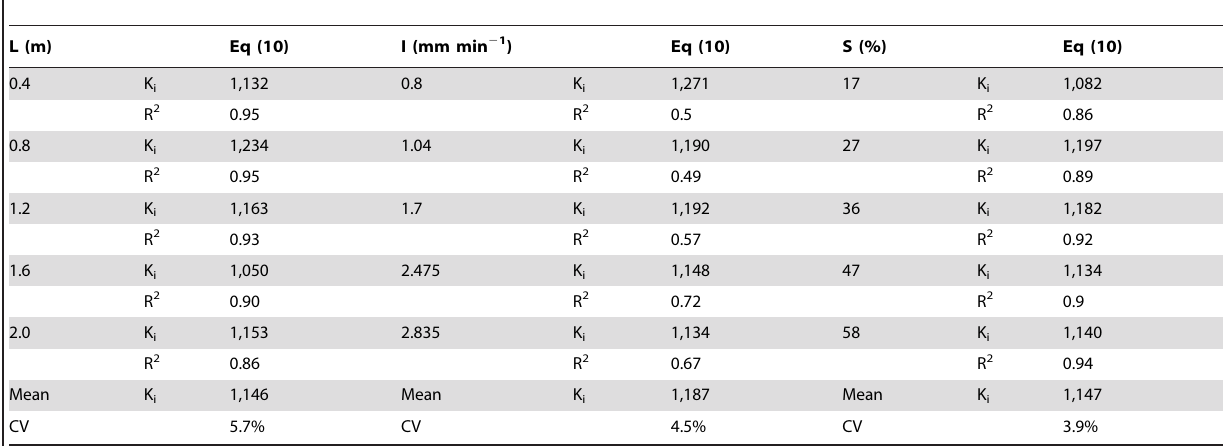
Table 5. Slopes of the linear regression ( K i ) and coefficients of determination ( R 2 ) from Eq (10) for different experimental conditions.